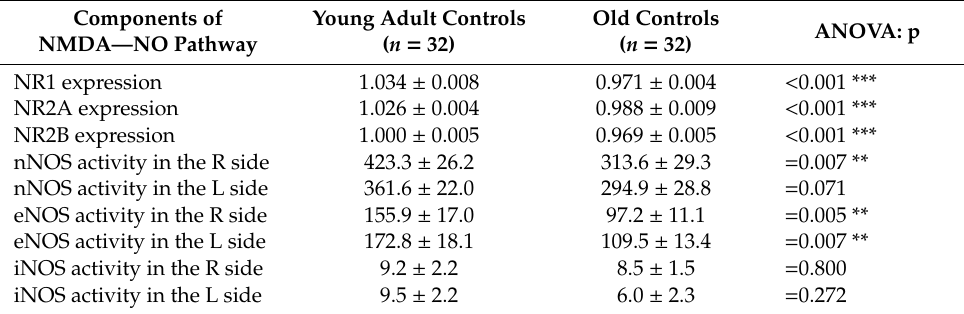
Table 2. Age-dependent changes in NMDA receptor—NO